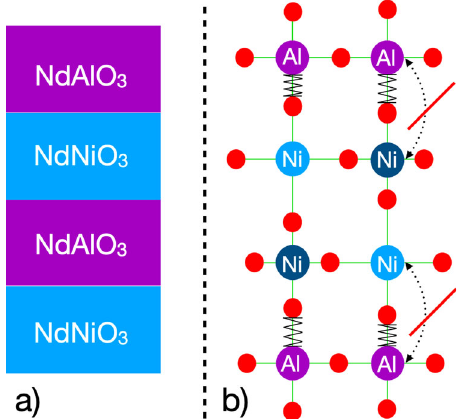
Fig. 5 Structural and electronic effects of layering NdNiO 3 with the band insulator NdAlO 3 . a Schematic of superlattice consisting of NdNiO 3 layered in between the band insulator NdAlO 3 ; b schematic view of two atomic layers of NdNiO 3 sandwiched between NdAlO 3 layers as described in ref. 4 . Dashed line with red slash: forbidden electronic hopping path, indicating mechanism of dimensional con fi nement. Zig-zag lines connecting O (red circles) and Al atoms: representation of the increased stiffness to distortions of apical Ni – O bonds as a result of resistance from the Al – O